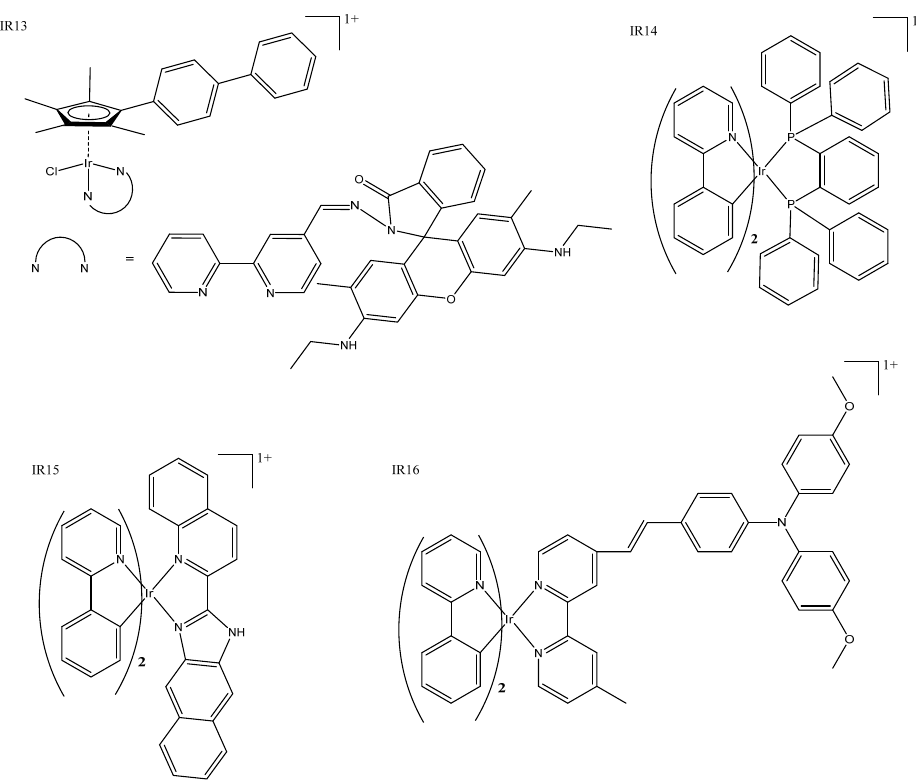
Figure 3. Iridium complexes: half-sandwich complex IR13 [34], cyclometallated complexes IR15 [37] and IR16 [38], and P^P complex IR14 [36].